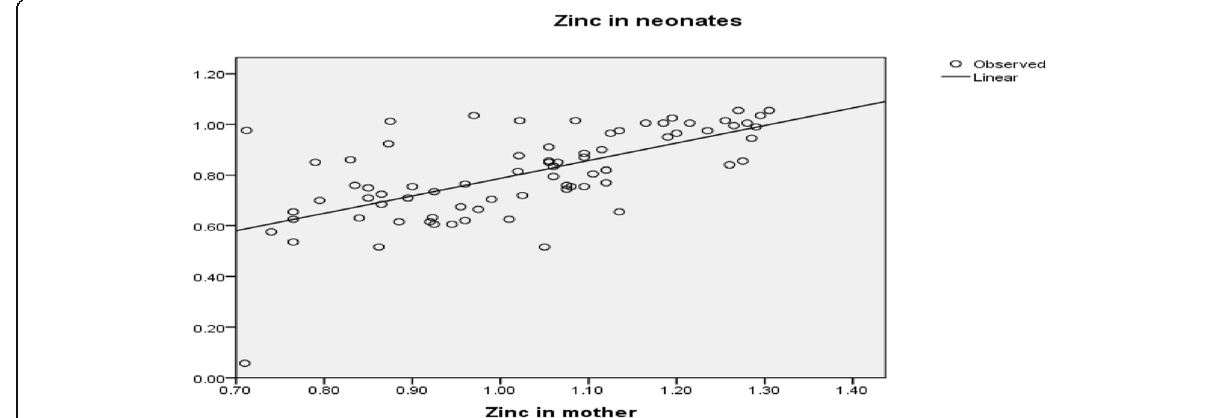
Fig. 1 Correlation between zinc level in neonates and zinc level in mothers